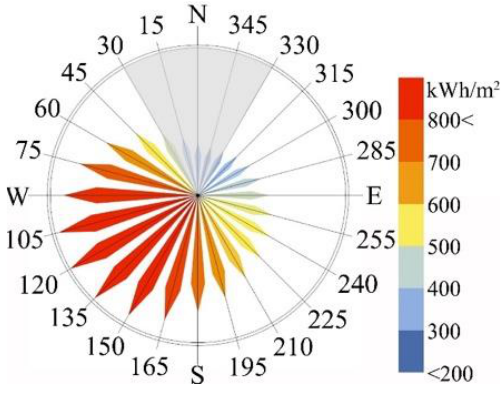
Figure. 14 The orientation distribution of total solar